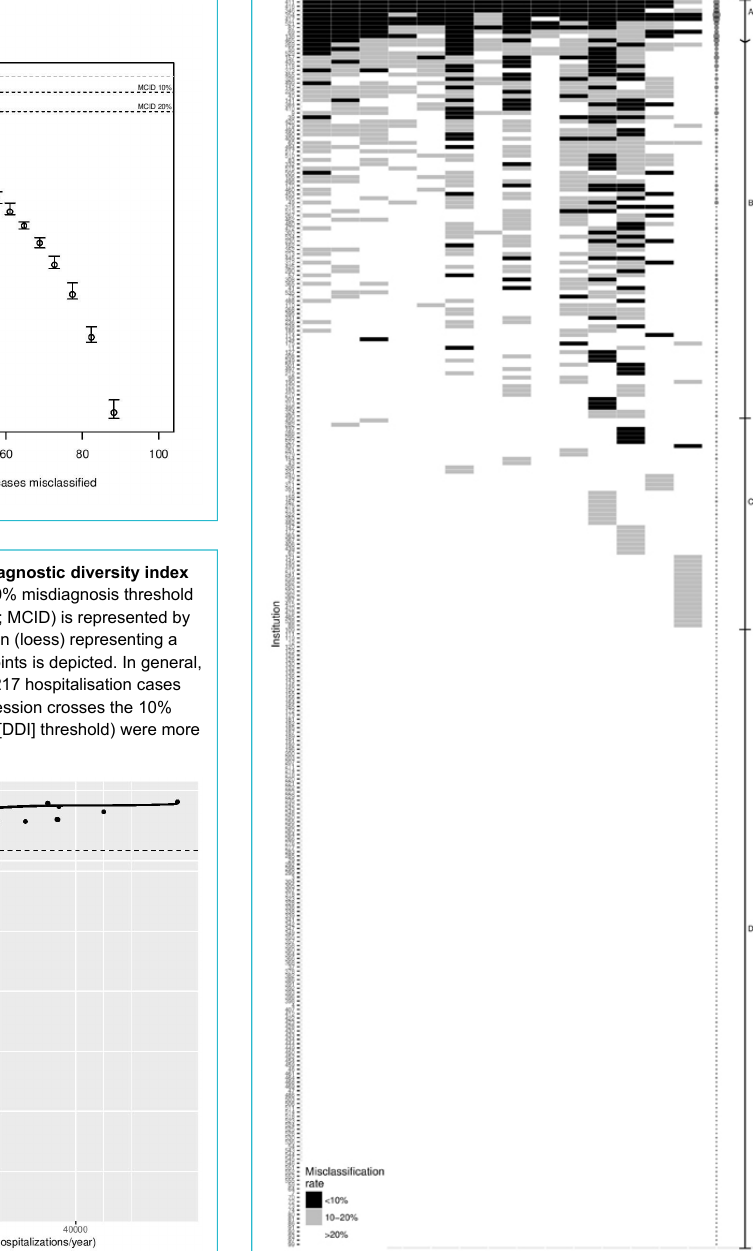
Figure 2: Diagnostic diversity index (DDI) benchmark – nu- merically simulated introduction of an increasing number of misdiagnoses and its effect observed on the DDI. The overall Swiss-wide DDI level (before simulation) is represented by a grey dashed line. The simulation of 10% of misdiagnoses – defined as MCID 10% – resulted in a DDI decrease of 0.12 points or 7.06 (blacked dashed line). A second cut-off set at 20% misdiagnosis (MCID 20%) is also represented (lower horizontal blacked dashed line).